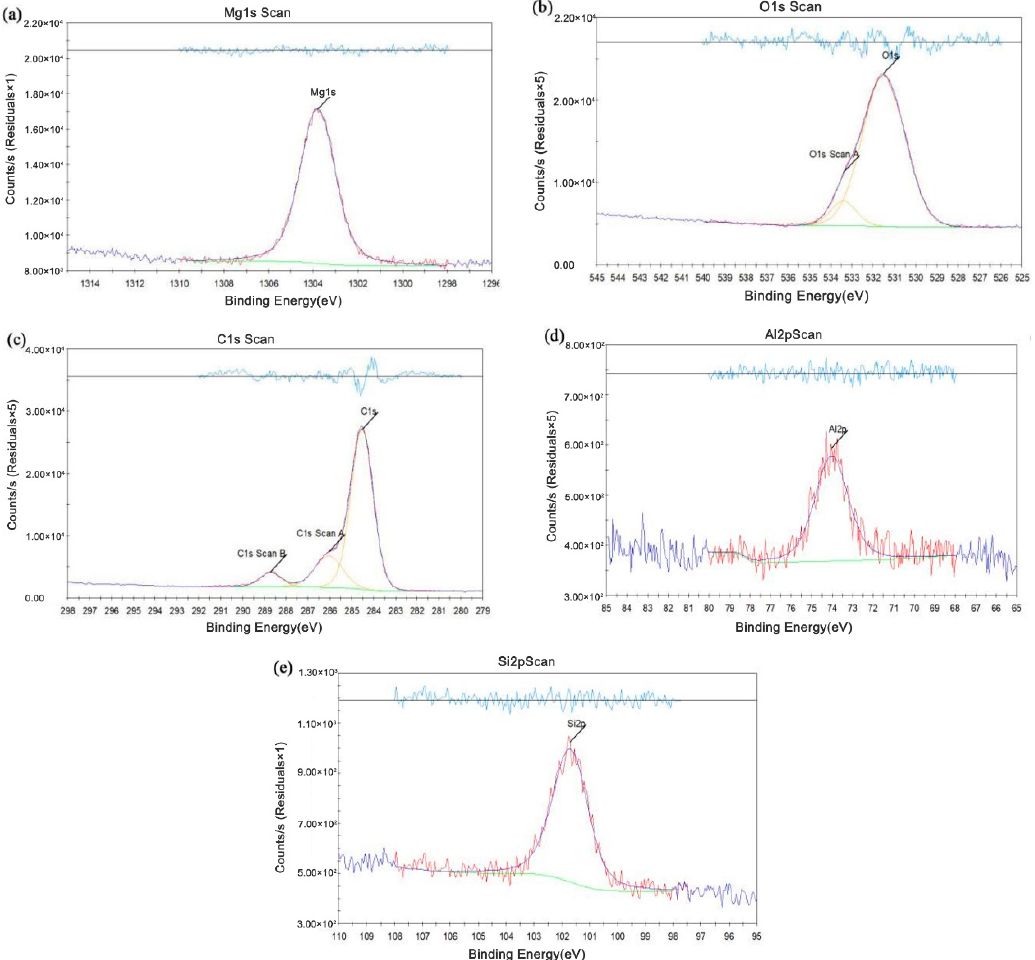
Figure 11. XPS of the interface in Figure 9d: ( a ) Mg, ( b ) O, ( c ) C, ( d ) Al, and ( e )